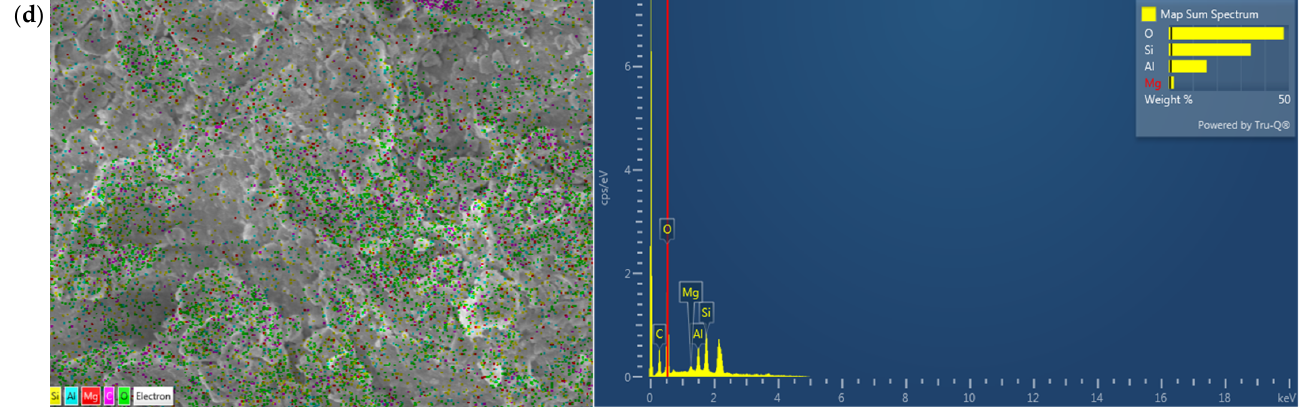
Figure 4. The SEM-EDS analysis of ( a ) RM, ( b ) BFS, ( c ) LPW, ( d ) NL.